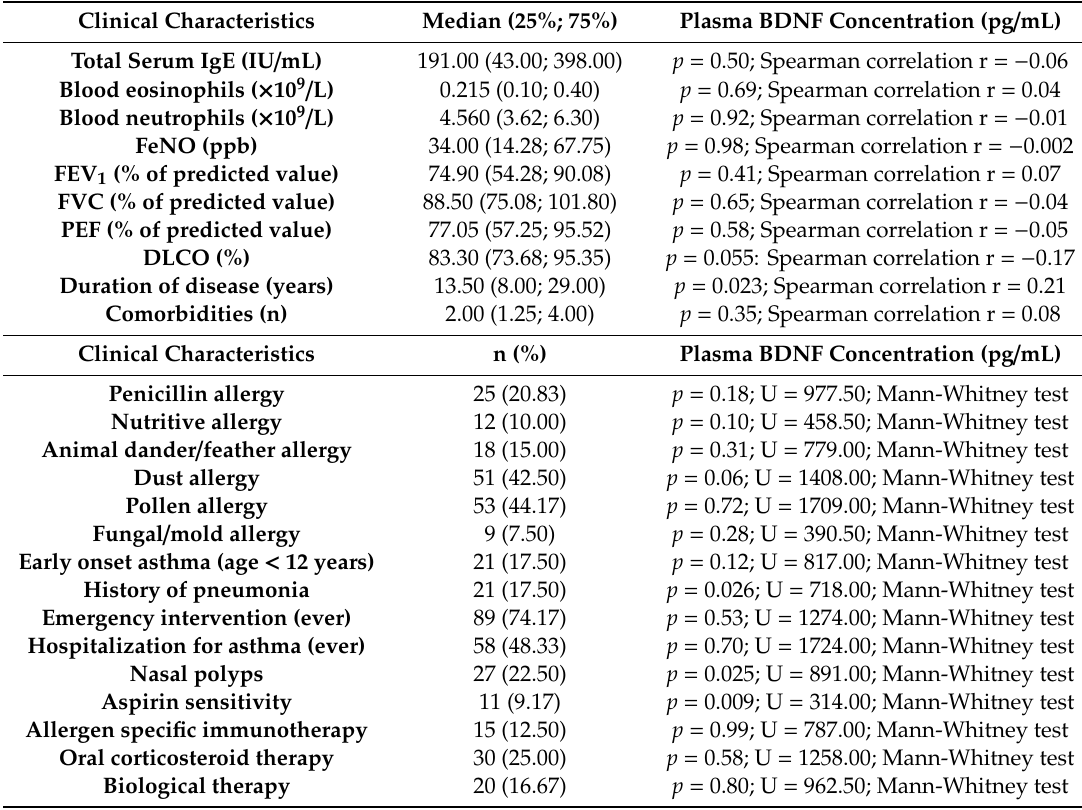
Table 8. The association of plasma BDNF concentration with clinical characteristics in asthma patients.